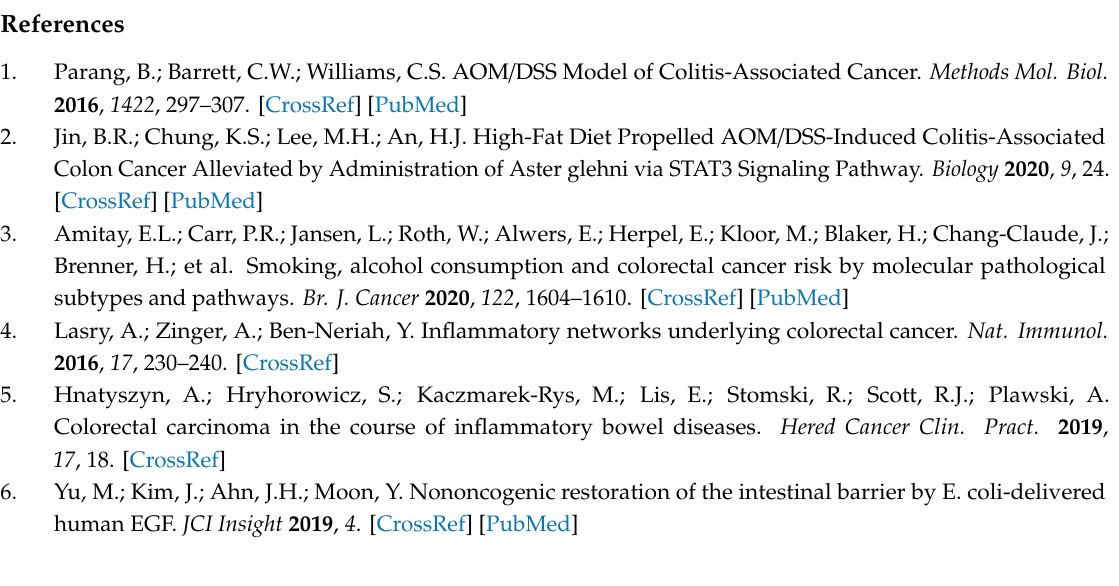
Figure S1: The expression of F. nucleatum 16s rRNA in representative CRC cells detected by RT-qPCR, Figure S2: E ff ects of F. nucleatum and P. gingivalis on representative CRC cells, Figure S3: Observation of spleen enlargement in each mice groups, Figure S4: Representative immunohistochemical staining images for Snail and E-cadherin in colon tissue, Figure S5: Prognostic importance of epithelial to mesenchymal transition markers in patients with CRC, Figure S6: Uncropped Western Blots of Figure 2B, Figure S7: Uncropped Western Blots of Figure 6A, Figure S8: Uncropped Western Blots of Figure 7A, Figure S9: Uncropped Western Blots of Figure 7C and Figure S10: Uncropped Western Blots of Figure